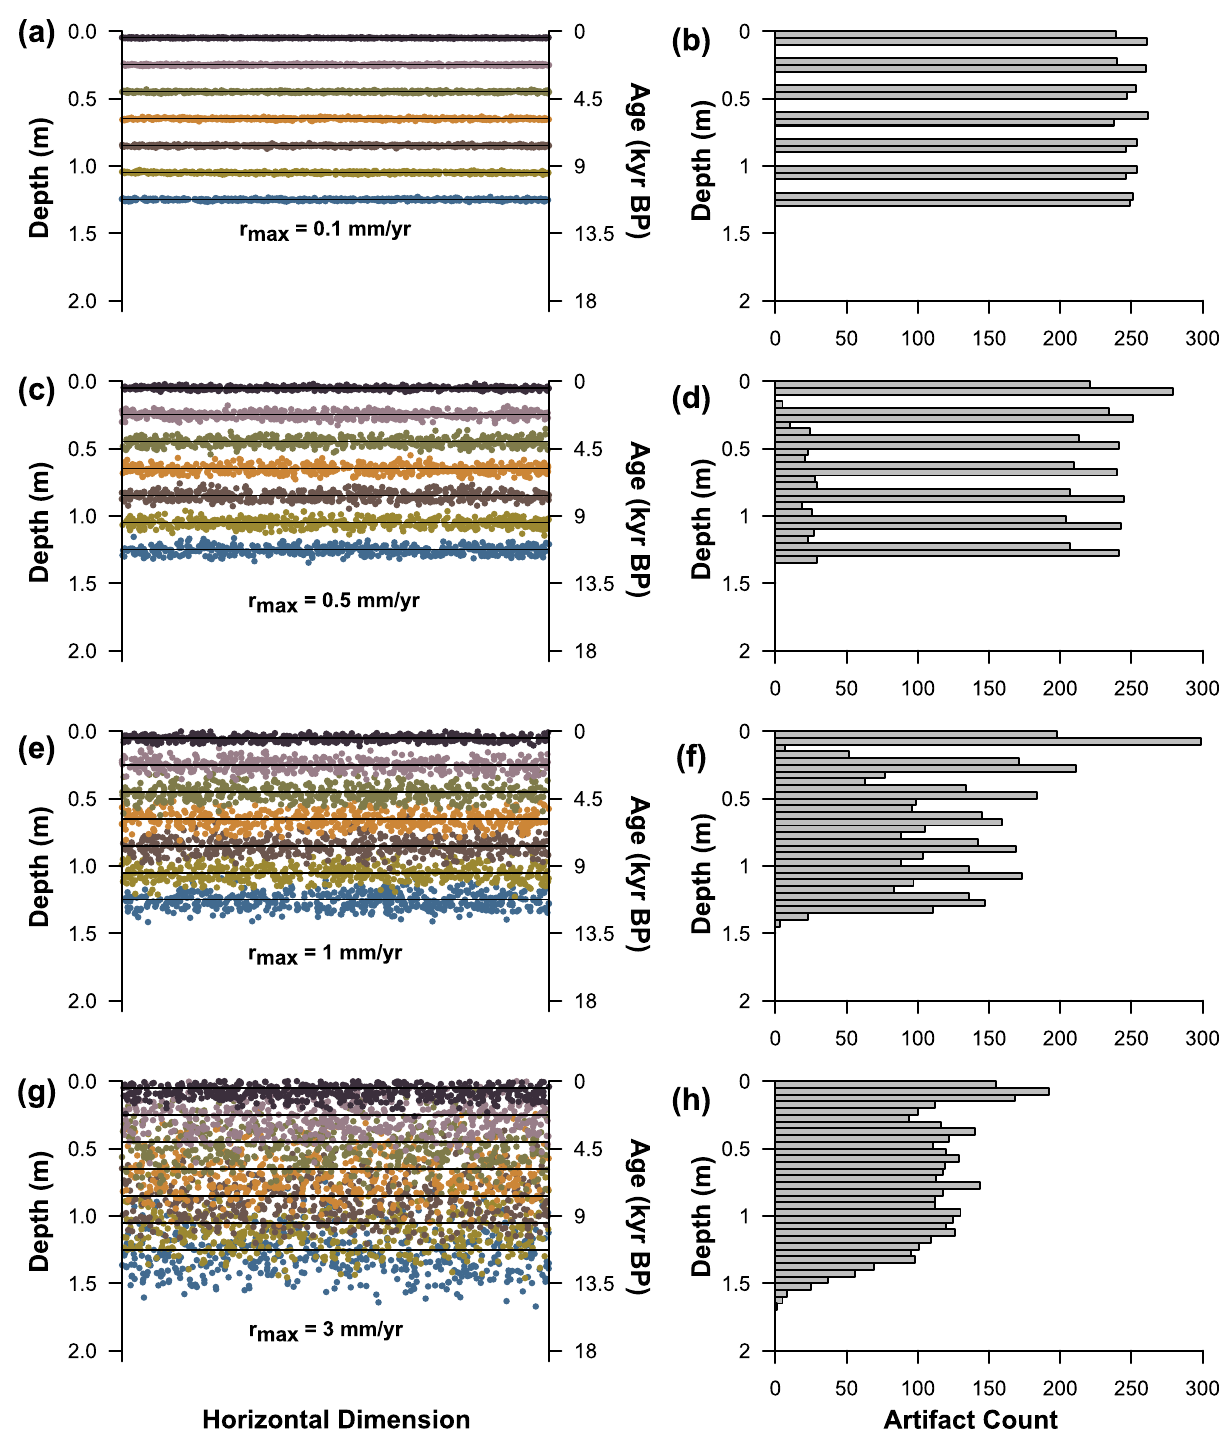
Fig 1. Simulations of stratigraphic mixing of a multicomponent archaeological site shown as backplots (left) and histograms of artifact elevation (right) while varying the maximum rate of artifact dispersal (r max ). Horizontal black lines on backplots show the original stratigraphic position of occupations before post-depositional disturbance. (a&b) r max = 0.1 mm/yr. (c&d) r max = 0.5 mm/yr. (e&f) r max = 1.0 mm/yr. (g&h) r max = 3.0 mm/yr.